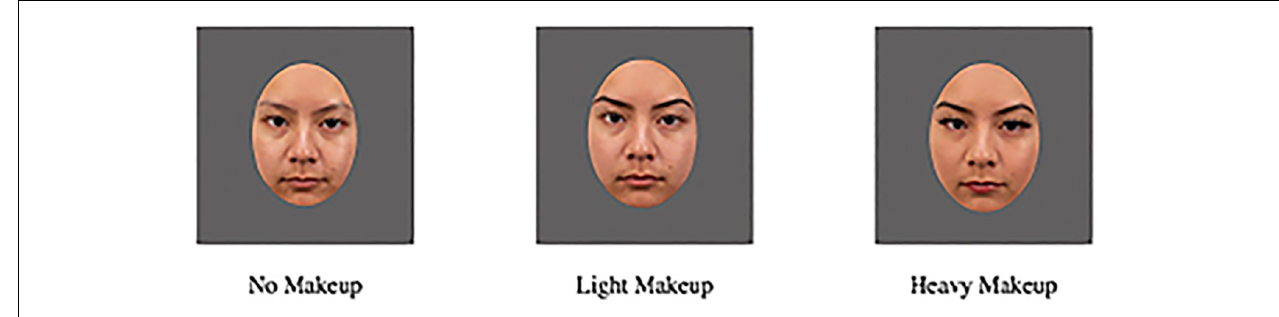
FIGURE 1 | Example of Facial Stimuli (No Makeup, Light Makeup, and Heavy